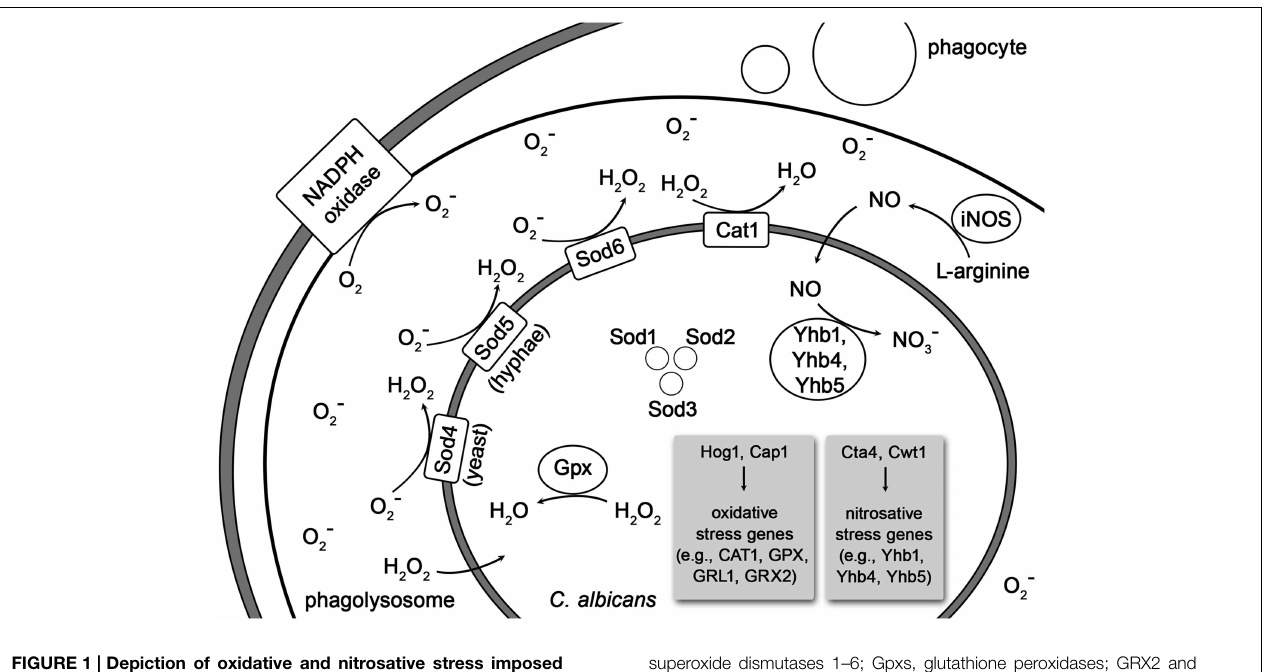
FIGURE 1 | Depiction of oxidative and nitrosative stress imposed on phagocytosed C. albicans and its detoxification by the fungus. The Curved lines indicate cell membranes of the phagocyte, the phagolysosome and, most inside, the C. albicans cell. Abbreviations: iNOS, inducible nitric oxide synthase; Cta1, catalase 1; Sod1-6,